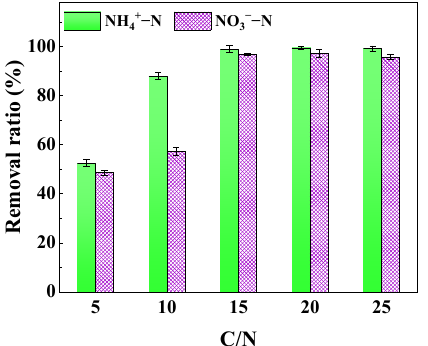
Figure 5. Influence of C/N on nitrogen compounds removal on Vibrio sp. LY1024.